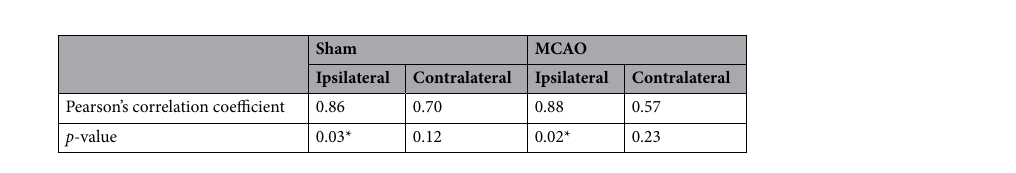
Table 2. Pearson’s correlation coefficient test. * p <